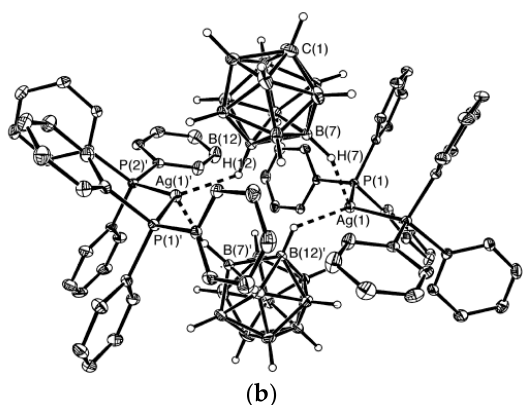
Figure 92. X-ray structures of {(Ph 3 P)Ag[CB 11 H 12 ]} ( a ) and {(Ph 3 P) 2 Ag[CB 11 H 12 ]} 2 ( b ). Reproduced with permission from reference [110]. Copyright © (2002) John Wiley & Sons.